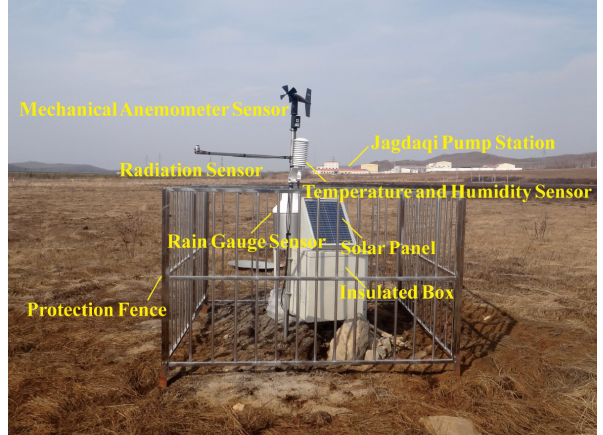
Figure B1. The automated weather station and instrumentations at the JB site along the China–Russia crude oil pipeline route in the northern Da Xing’anling Mountains, Northeast China. Notes: photo was taken on 10 April 2018. The rain gauge sensor has been in- stalled but is ineffective. The photo shows the location of the Jag- daqi pump station. The CR3000 data logger, multiplexer, battery cell, solar charge controller, and wireless transmission module are placed in the white box with a solar panel (i.e., insulated box). All monitoring devices are protected by an aluminum alloy